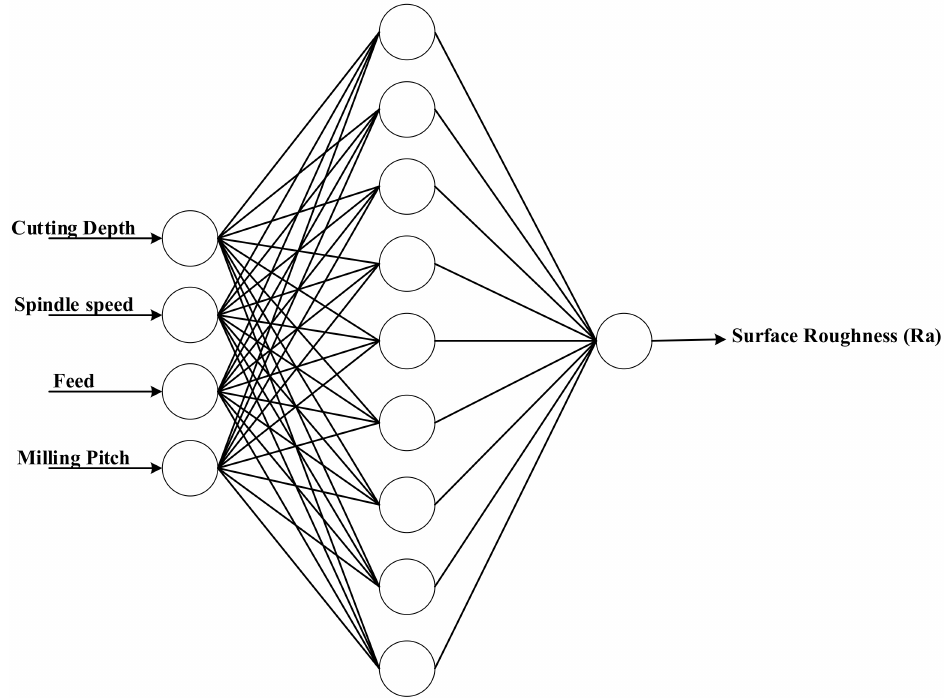
Figure 7. Proposed BPNN